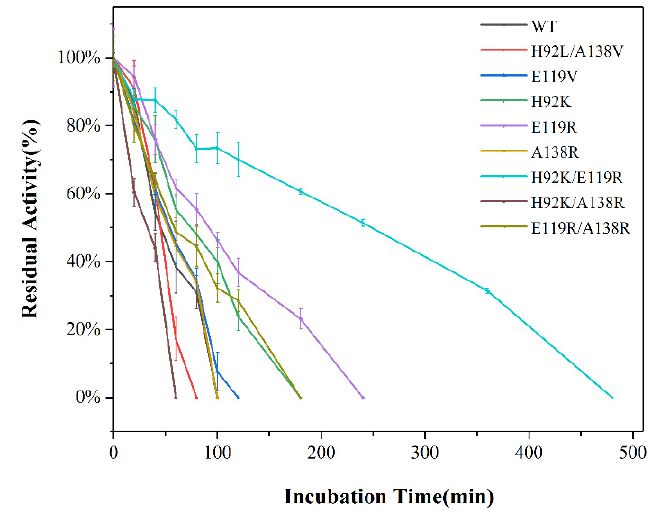
Figure 5. Thermal stability of WT, H92L/A138V, E119V, H92K, E119R, A138R, H92K/E119R, H92K/A138R, and E119R/A138R at 50°C. Heat treatment at 50°C for 0–480 min, with the reflected enzyme activity of each enzyme without heat treatment recorded at 100%. Determination of the residual vitality, where the value of each data point represents the average value.